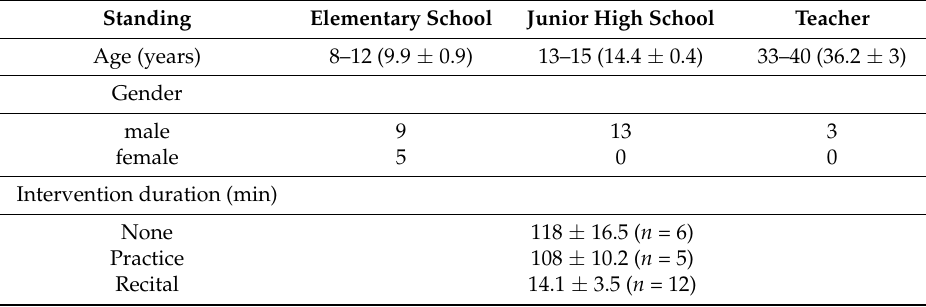
Table 1. Demographic